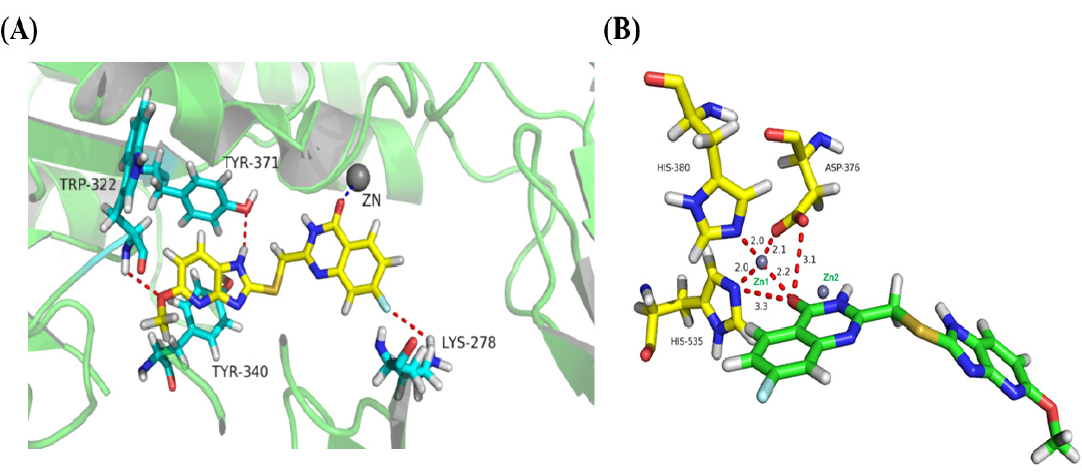
Figure 6. ( A ) Representation of the predicted binding modes of compound 4e with ENPP1 domain (PDB code 6WFJ). ( B ) OMIT maps of compound 4e bound to ENPP1. The two Zn atoms are shown as black spheres and Asp376; His380 and His535 are highlighted in stick representation.